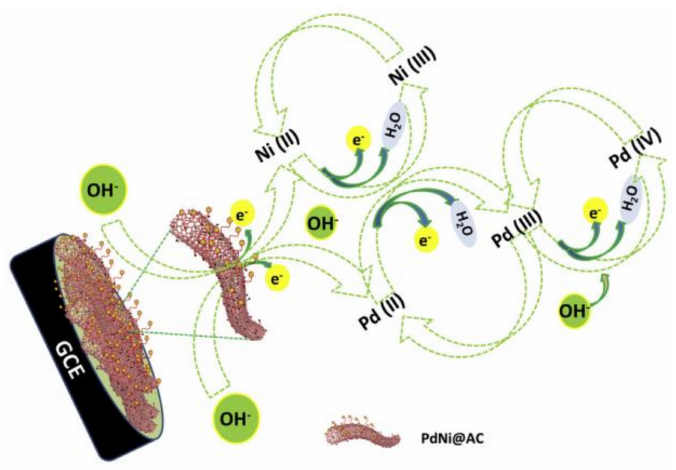
Figure 15. Mechanism involved during activation of Ni-Pd@AC/GCE surface in NaOH solution, reproduced with permission from